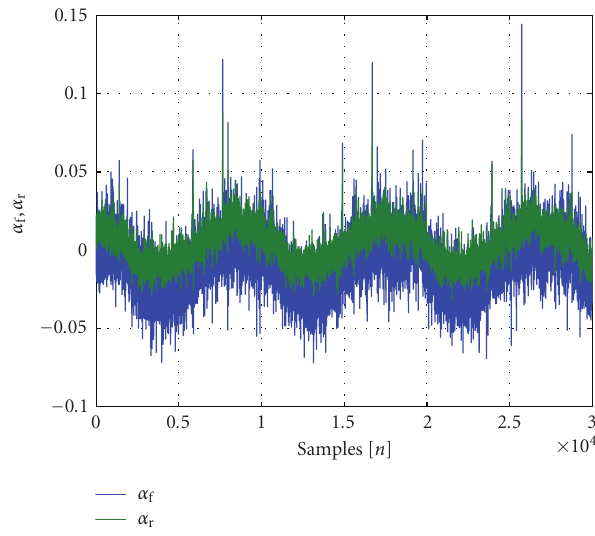
Figure 6: The skewness component is removed from the two resid- uals α f [ n ] and α r [ n ] computed for a disc with a scratch and a skew- ness